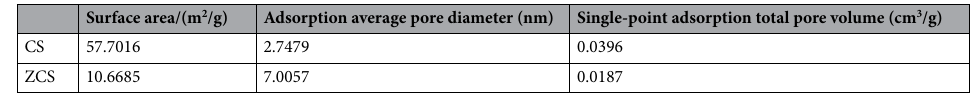
Table 2. Brunauer–Emmett–Teller analysis of biochar before and after anaerobic digestion.